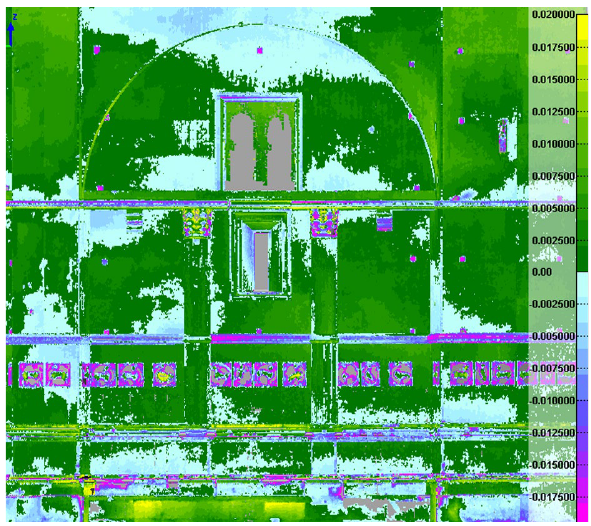
Figure 5. Particular of the comparison map [m] between the TLS point cloud and the 3D model of the